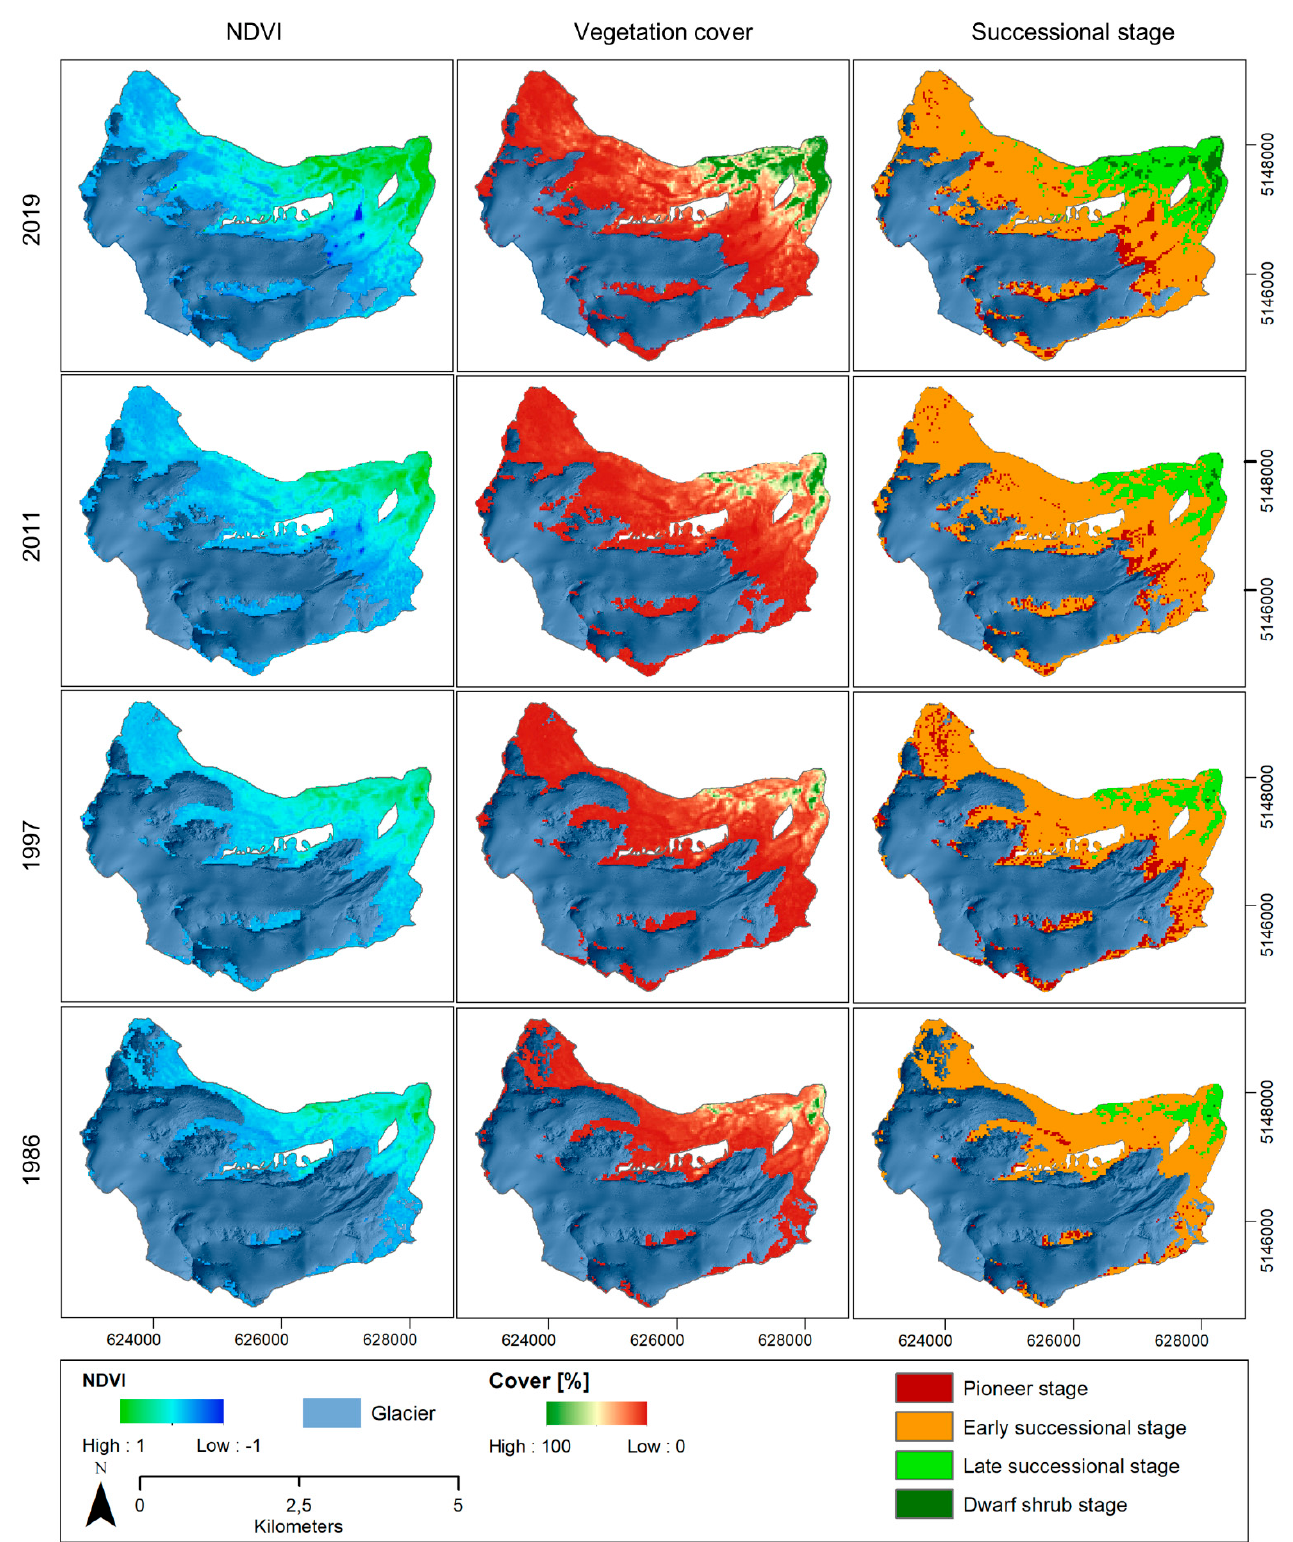
Figure 4. Vegetation modelling in the glacier forelands: 2019–2011–1997–1986. Results are based on in-situ investigations and the NDVI and are presented area-wide as vegetation cover (%) and classified successional stages.